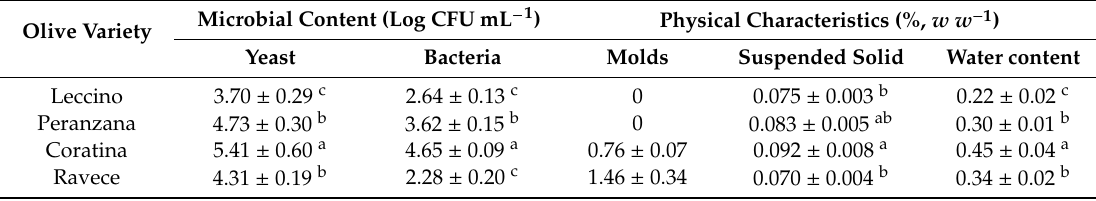
Table 1. Microbial and physical characteristics of newly extracted monovarietal extra virgin olive oils